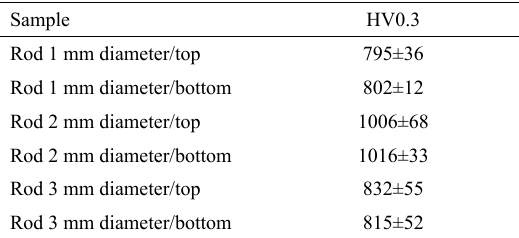
Table 1. Vickers microhardness results of the top and bottom region of 1, 2 and 3 mm diameter rods.